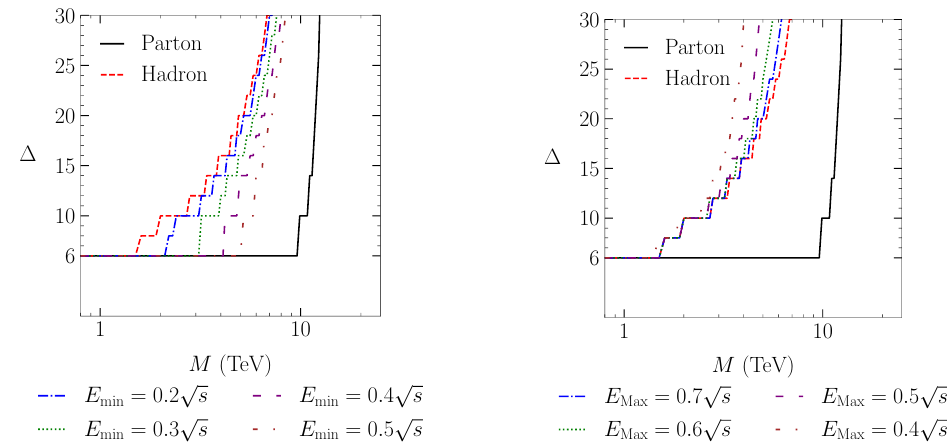
Figure 18 . Perturbative unitarity bounds in the ∆ versus M plane for various choices of a minimum energy cut E min [left] and of a maximum energy cut E max [right] for the t -channel model with λ qφ = 8 π . The region that is incompatible with hadronic perturbative partial-wave unitarity is to the left of the